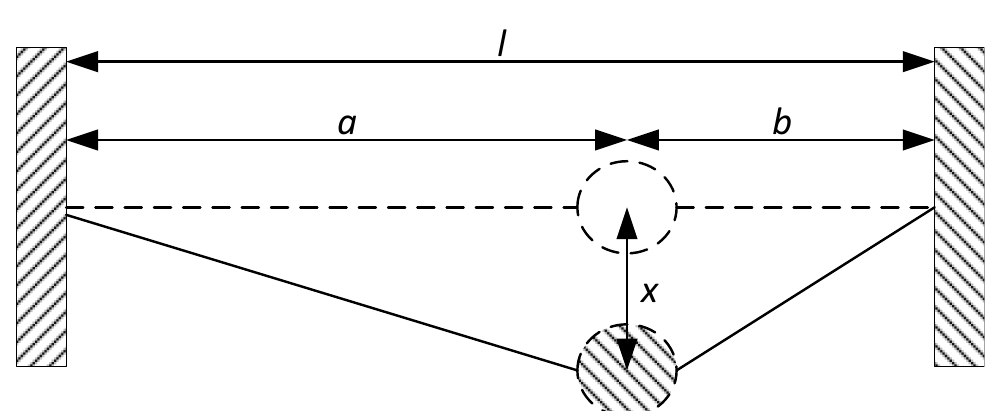
Figure 1. Illustration of the weighted string mechanical system, Reprinted with permission from ref. [33]. Copyright 2010 McGraw-Hill